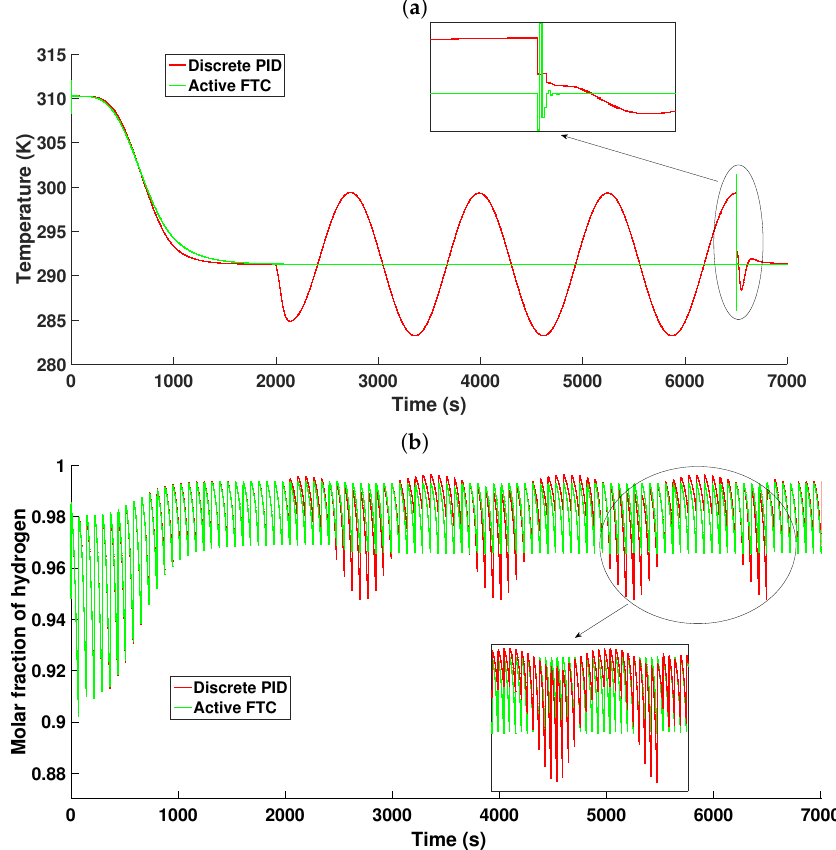
Figure 24. Scenario 2 − Individual fault: ( a ) control signal generated by the active FTC and discrete PID controller, and ( b ) hydrogen purity with sine wave-type actuator fault on the PSA virtual